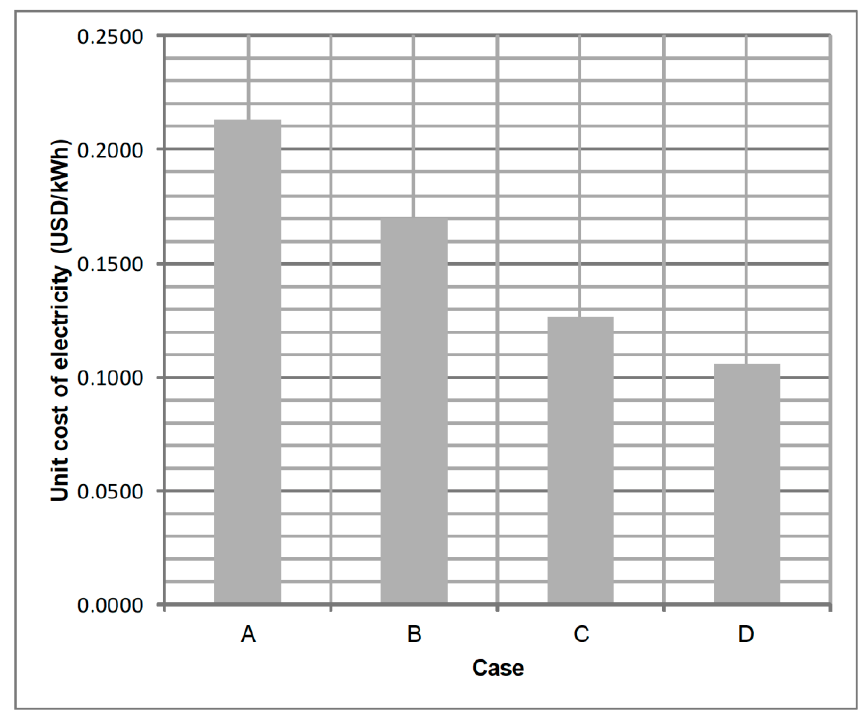
Figure 5. Comparison of the four cases under study in terms of the unit cost of electricity (in USD/kWh).